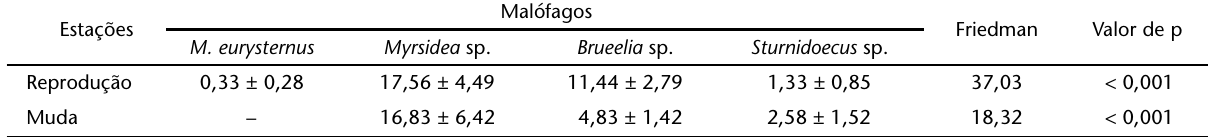
Tabela III. Comparação entre as intensidades relativas dos malófagos observados em T . leucomelas nas estações de reprodução e troca de penas (outubro e dezembro 2006/março 2007) no Parque Estadual do Rio Preto (média ± erro padrão, Gl = 3, (cid:2) = 5%.).